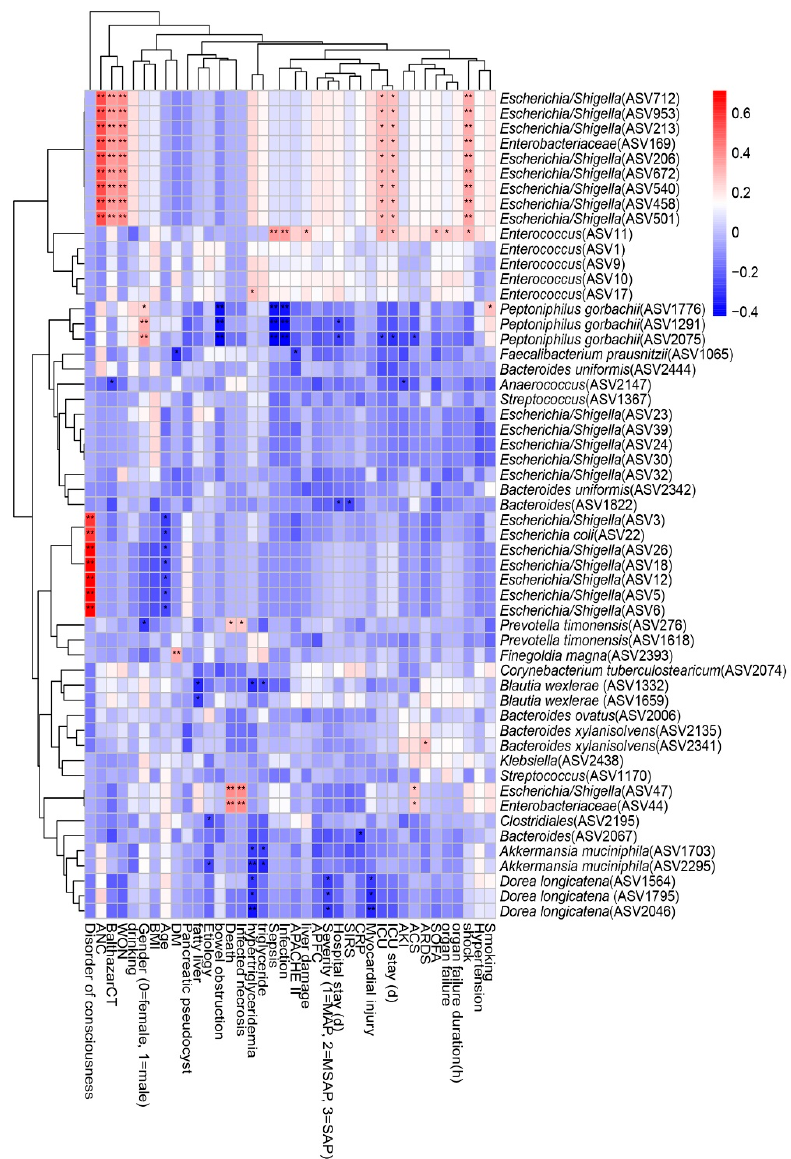
Figure 6. Spearman correlations between differential ASVs and clinical outcomes as well as indicators of disease severity. ASV, amplicon sequence variants; ANC, acute necrotic accumulation; WON, walled-off necrosis; BMI: body mass index; DM, diabetes mellitus; APACHE II: the Acute Physiology and Chronic Health Evaluation II score; APFC, acute peripancreatic fluid collection; MAP: mild acute pancreatitis; MSAP: moderately severe acute pancreatitis; SAP: severe acute pancreatitis; SIRS: systemic inflammatory response syndrome; CRP: C-reactive protein; ICU: intensive care unit; AKI: acute kidney injury; ACS: abdominal compartment syndrome; ARDS: acute respiratory distress syndrome; SOFA: the Sequential Organ Failure Assessment score. The strength of positive (red) or negative (blue) correlation is shown by two-color heatmap, with asterisks denoting statistical significance (* p < 0.05, ** p <